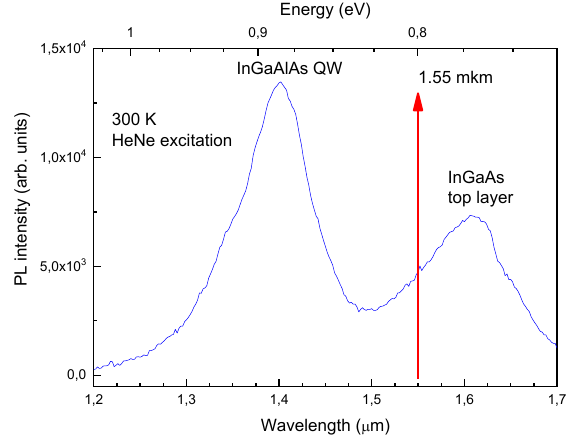
Fig. 3. Typical photoluminescence spectrum of the HES with InGaAlAs/InAlAs multiple quantum wells.